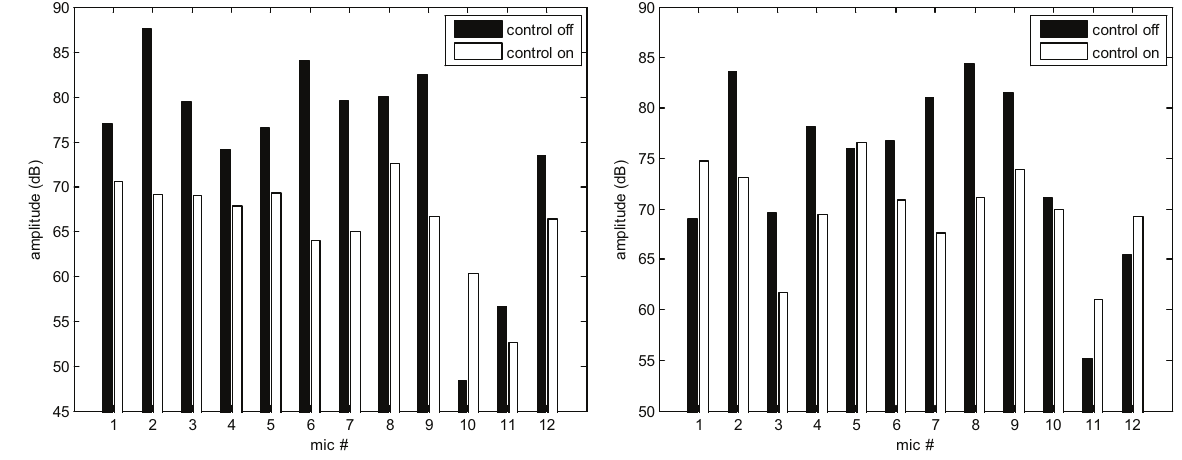
Fig. 14. Principal component LMS results for f2 tone. Fig. 15. Principal component LMS results for f3